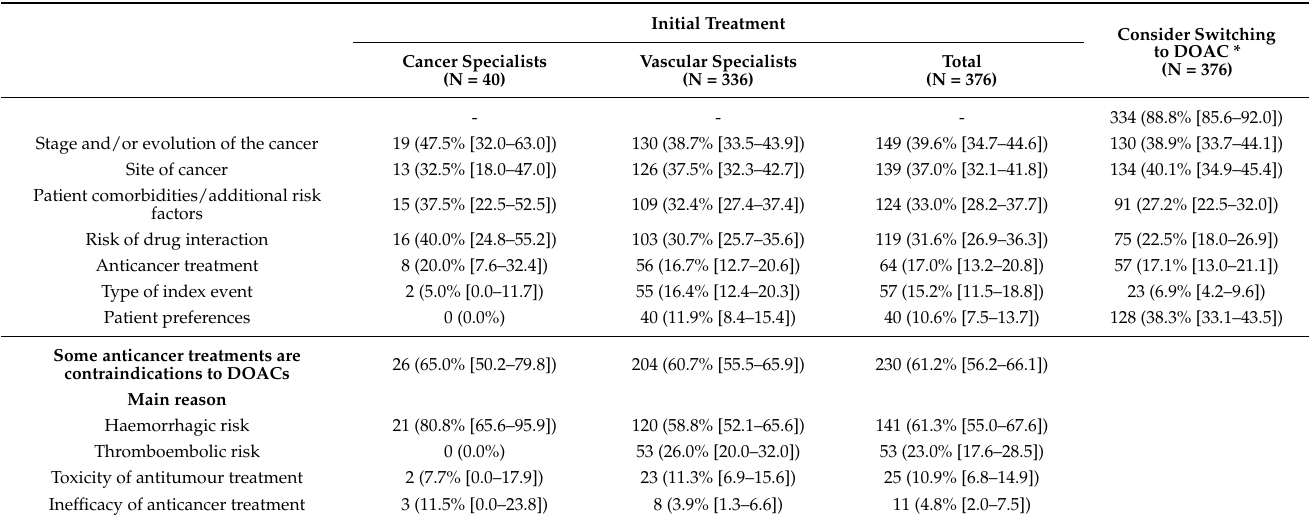
Table 2. Determinants driving the treatment decision of the initial anticoagulant treatment of CAT; and decision to switch to DOACs in patients started on LMWHs, according to the medical speciality.